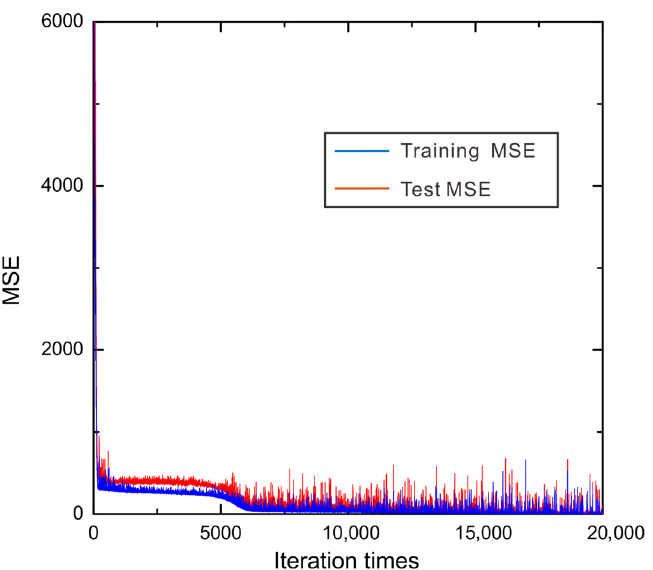
Figure 3. The training and validating MSEs varying with the iteration times for evaluating the thermal conductivity for the WC-Ag system. Table 1. The training and test R 2 scores of 10-fold cross validation for evaluating thermal conductivity for WC-Ag system. The average R 2 is shown in the last